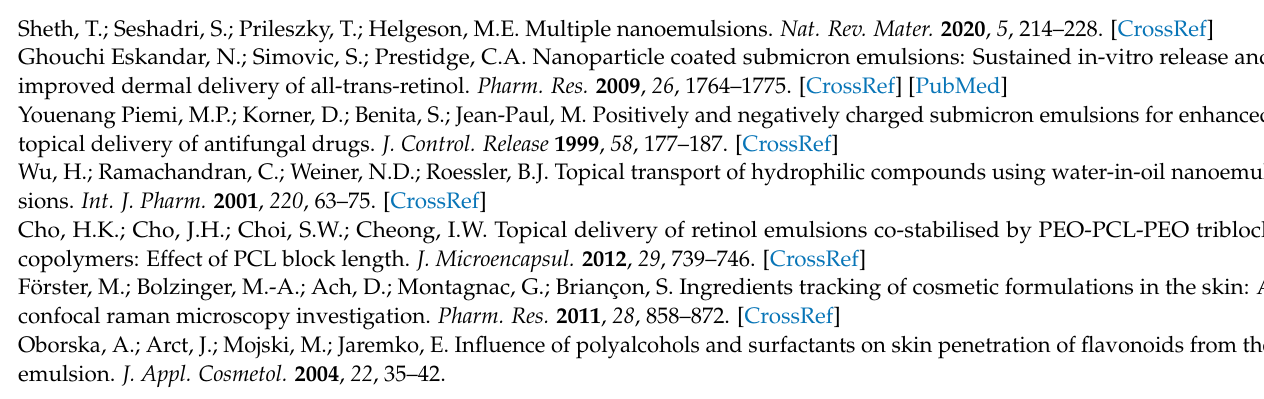
Figure S6: All cumulative release curves of griseofulvin from all the investigated formulations; Table S1: Non-parametric data distribution fits—release profiles of redispersed emulsions; Table S2: Non-parametric data distribution fits—release profiles of lyophilized powders; Table S3: Non- parametric data distribution fits—release profiles of emulsions; Table S4: Non-parametric data distribution fits—release profiles of hyaluronic acid formulations; Table S5: Non-parametric data distribution fits—release profiles of amylopectin formulations. Table S6: Non-parametric data distribution fits—release profiles of alginic acid